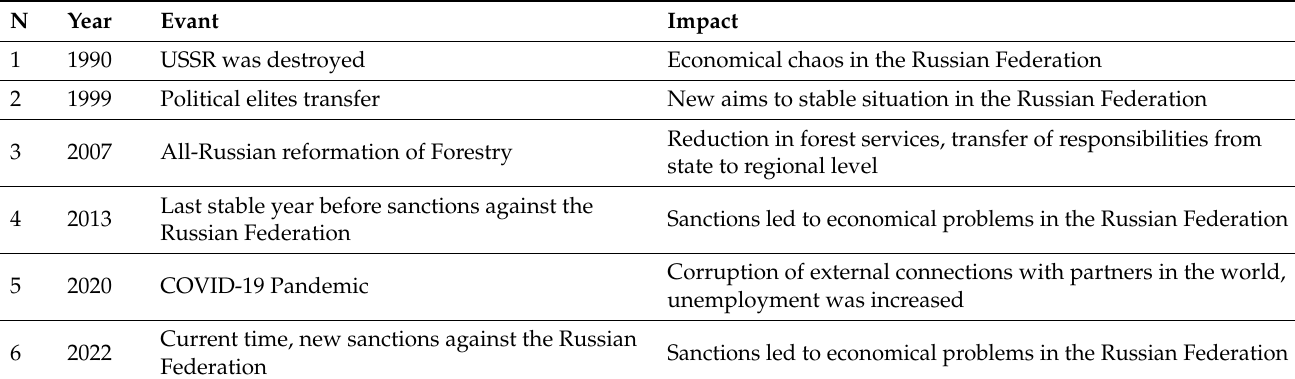
Table 4. Control points in chronological